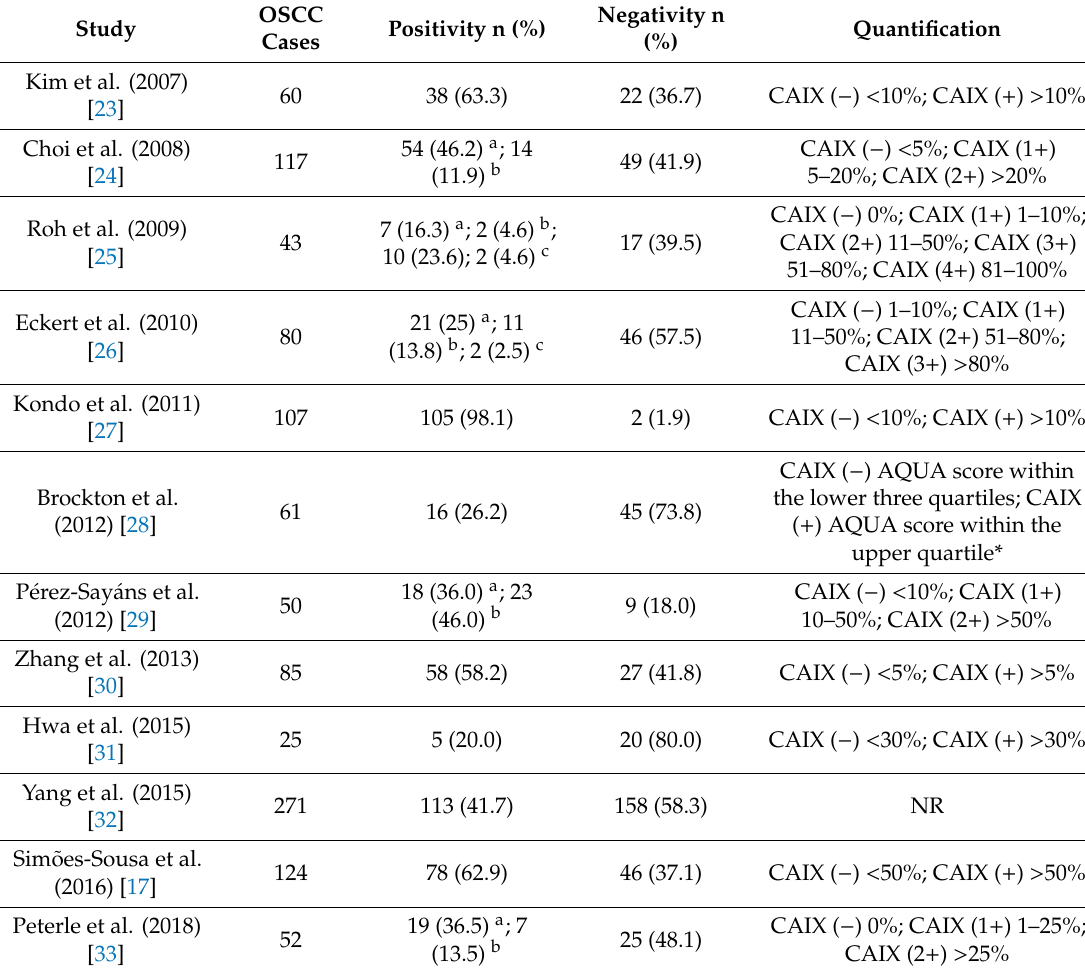
Table 1. CAIX immunohistochemical expression in oral squamous cell carcinoma (modified from P é rez-Say á ns et al. (2012)